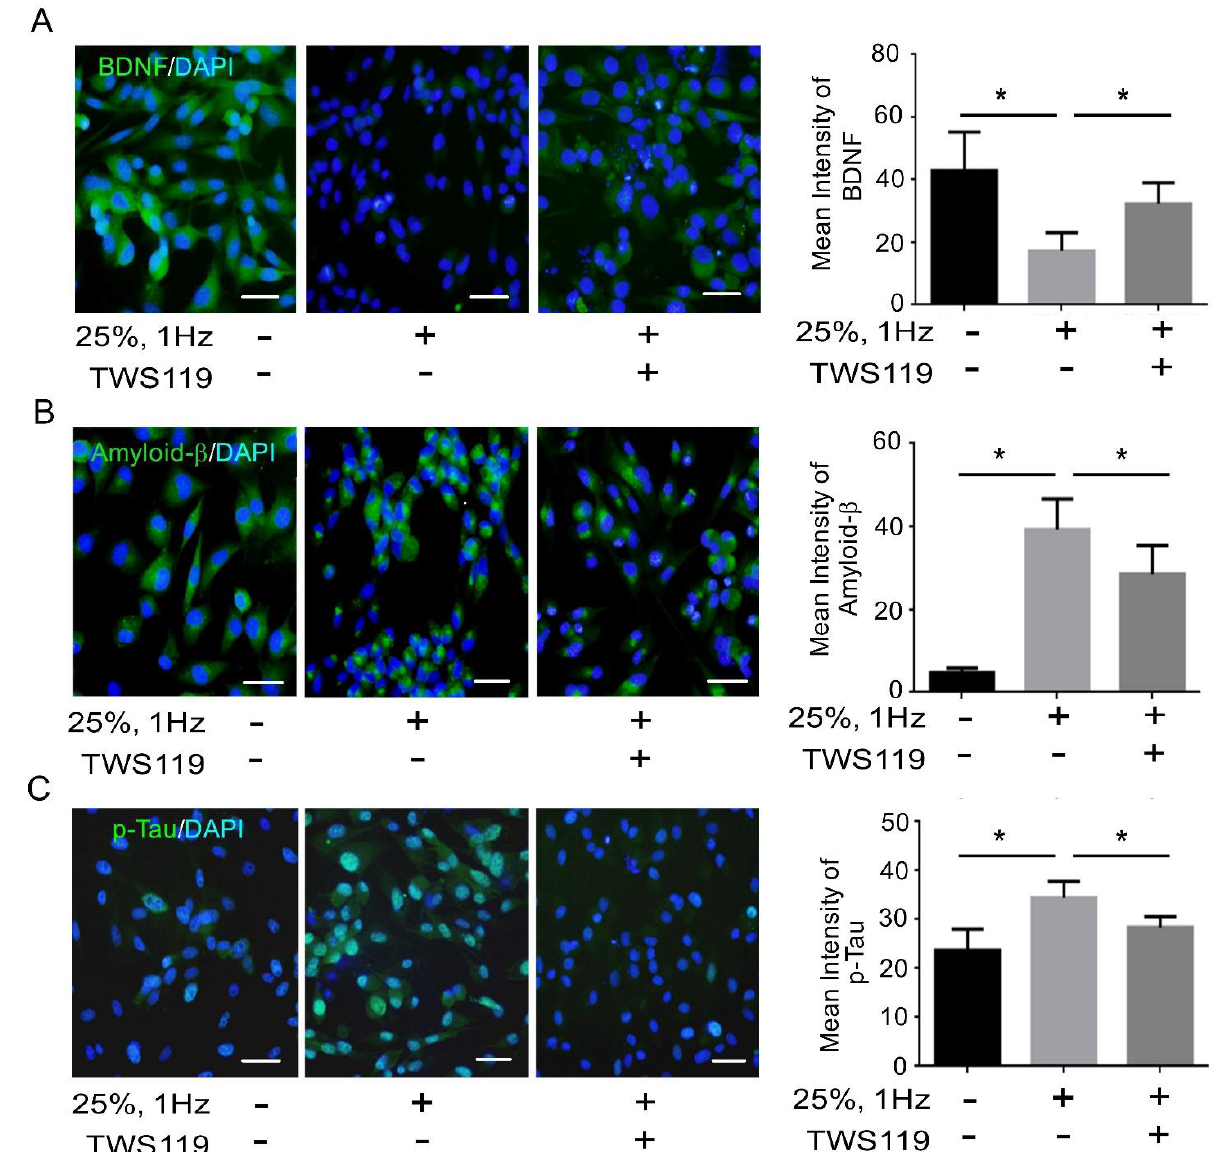
Figure 5. P-GSK3 β reduces BDNF levels and upregulates amyloid β /p-Tau expression in the neuron injury model. ( A – C ) Representative green fluorescence images of BDNF, amyloid β , and p-Tau S396 positive cells in SH-SY5Y cells, before and after stretching or TWS119 administration. The nuclei of SH-SY5Y cells were counterstained with DAPI and exhibited blue fluorescence. Bar graphs are representative of the BDNF, amyloid β , and p-Tau S396 fluorescence intensity in the SH-SY5Y cells of the indicated groups. The BDNF fluorescence intensity increased substantially in the 25%, 1 Hz-TWS119 group, with diminished amyloid β and p-Tau S396 intensity. The values are presented as means ± SEM ( n = 6); * p < 0.05. BDNF, brain-derived neurotrophic factor. Scale bar = 200 μm.